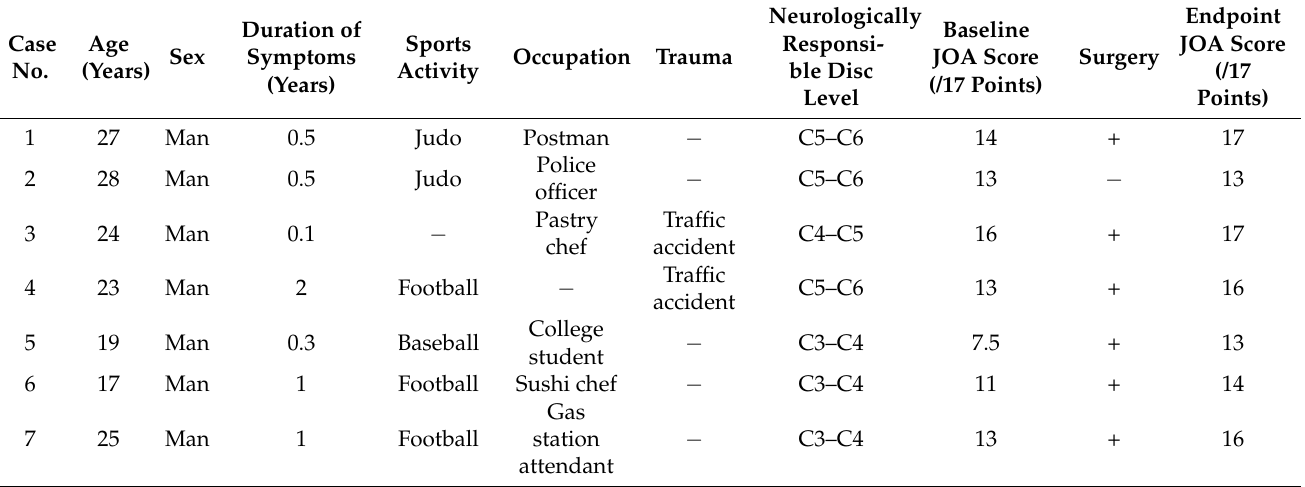
Table 1. Clinical characteristics of young adult patients with cervical spondylotic myelopathy under age